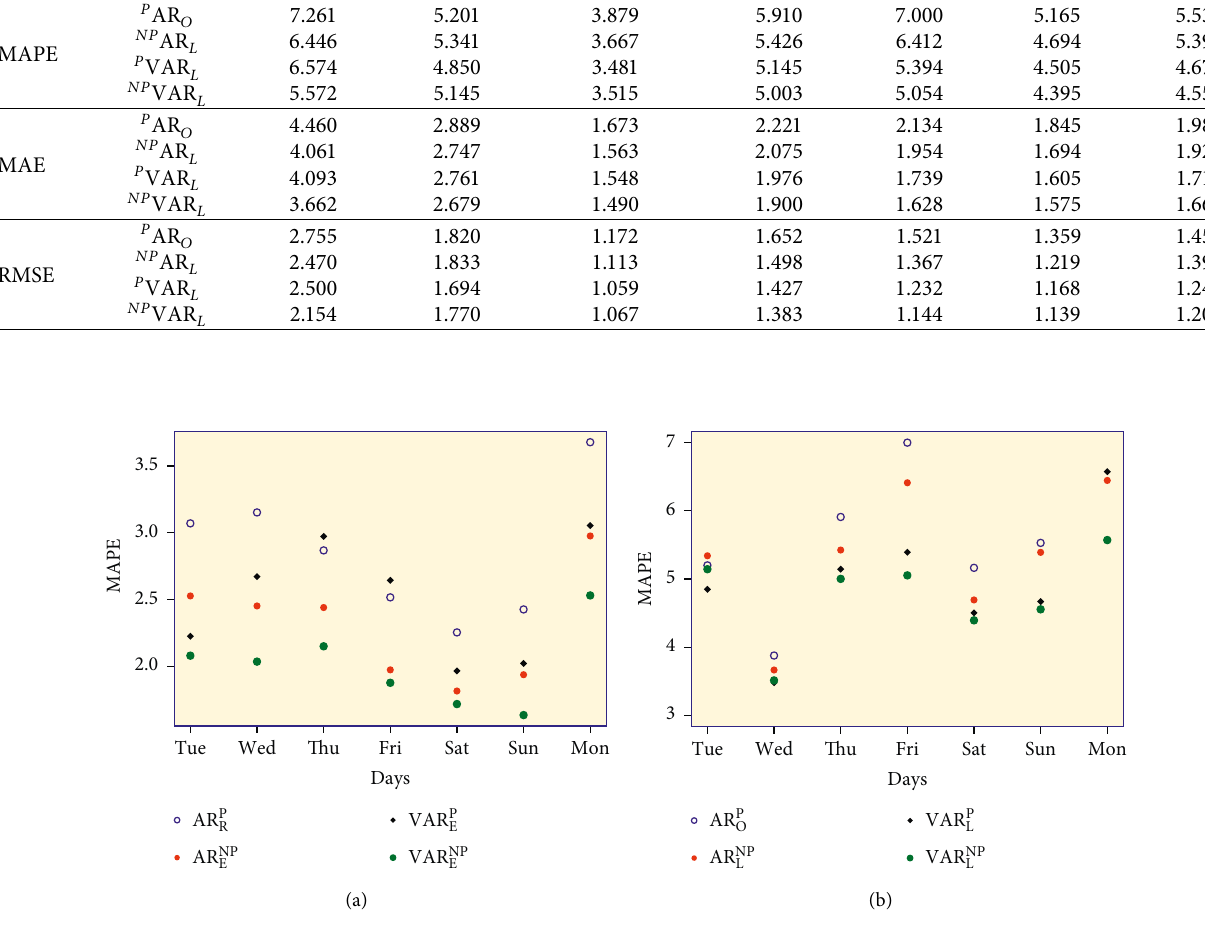
Figure 4: Day-specific MAPE for the best univariate and multivariate models. (a) Demand and (b)